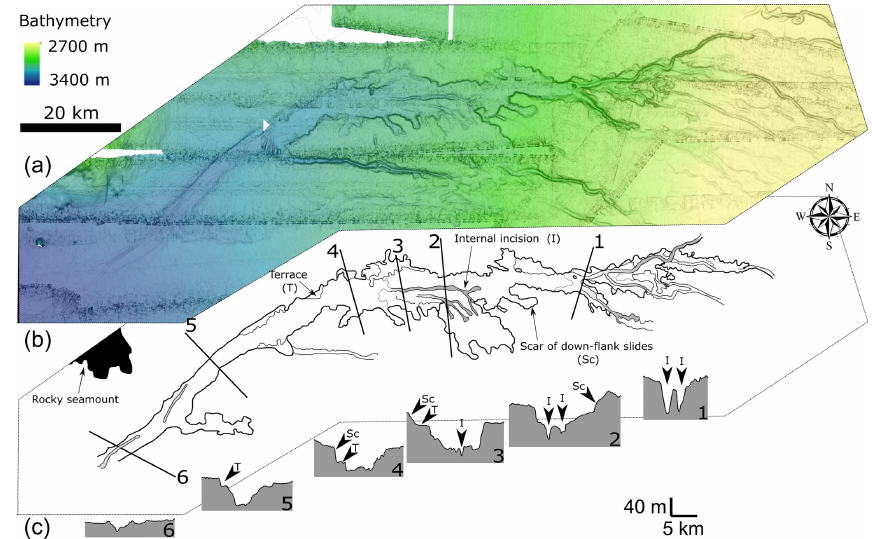
Figure 9. (a) Detailed bathymetric map of the mid-system valley of the Ogooue Fan between 2700 and 3400m water depth. (b) Interpretation of the main morphological features of the valley. (c) Six transverse profiles of the mid-system valley extracted from the bathymetry data (Sc: scar of down-flank slides; I: internal incision; T: terrace).